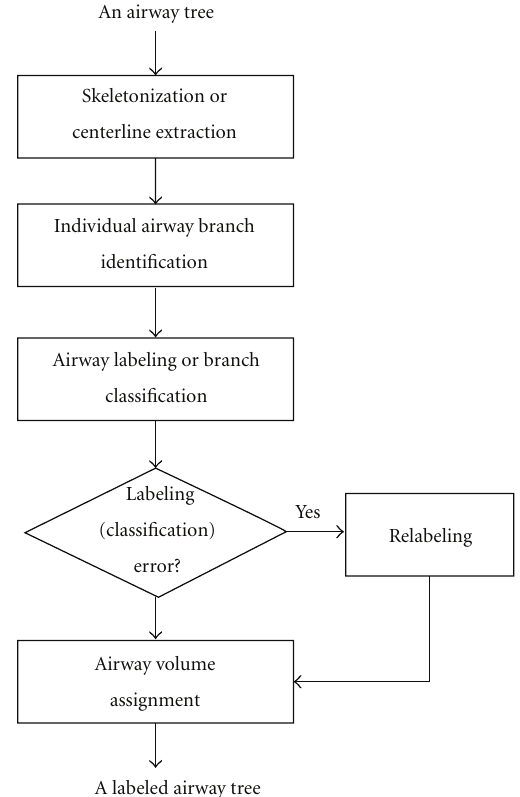
Figure 1: A flow chart illustrating the procedures of the developed airway labeling